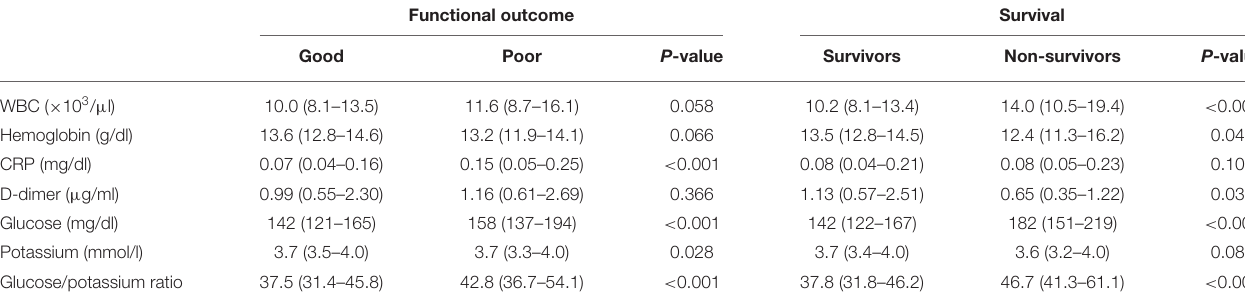
TABLE 3 | Comparison of glucose and potassium levels and other biomarkers according to outcome. Functional outcome Survival Good Poor P -value Survivors Non-survivors P